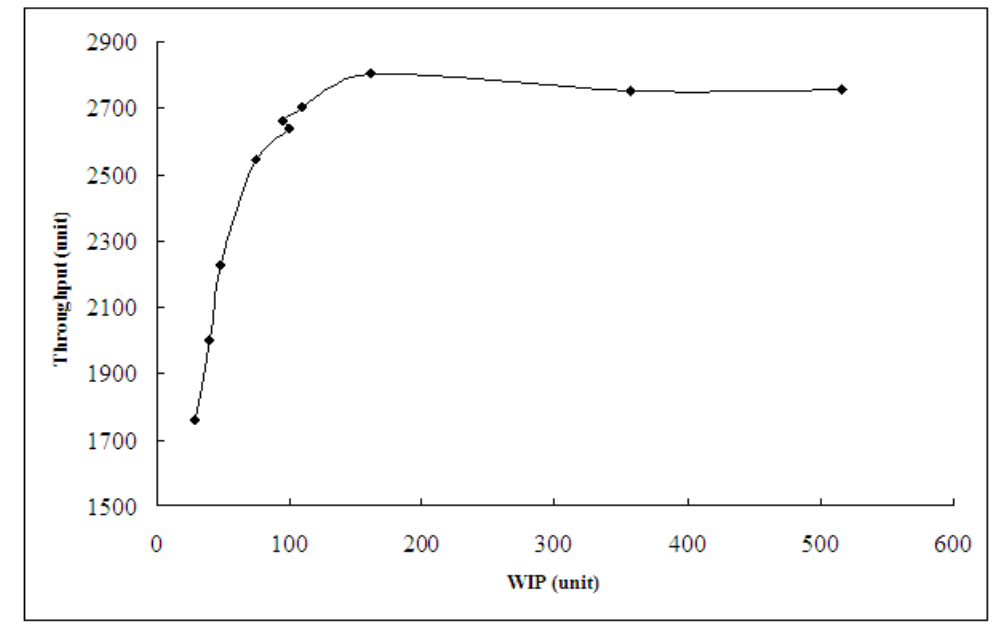
Figure 4. WIP vs. throughput of one old one new mills scenario